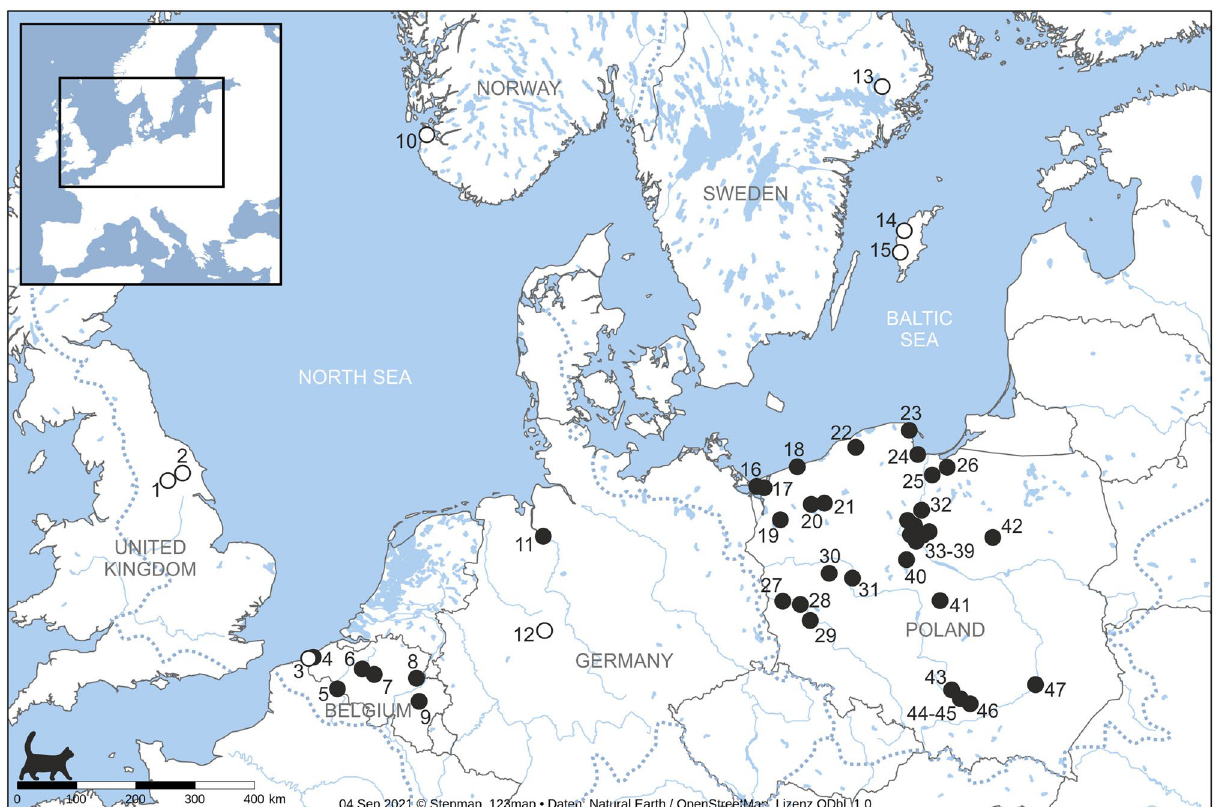
Figure 1. Locations with medieval and post-medieval cat remains studied for stable isotopes (1—York, 2—Wharram, 3—Koksijde, 4—Nieuwpoort, 5—Tournai, 6—Brussel, 7—Aalst, 8—Tongeren,